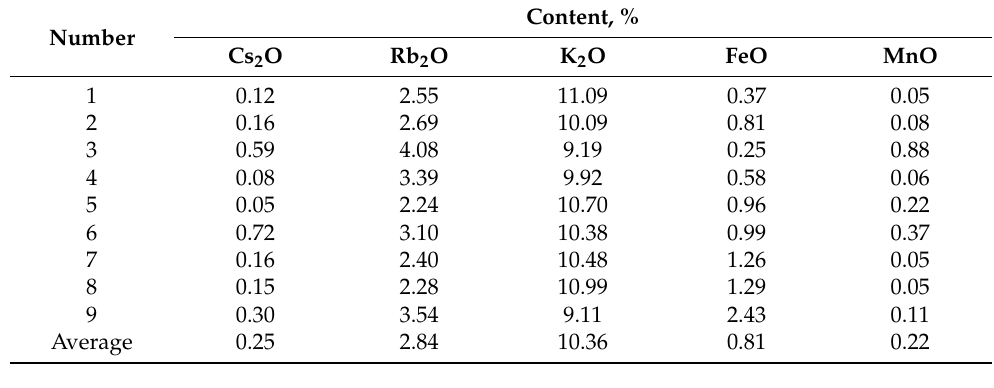
Table 7. Energy spectrum micro-domain composition analysis of mica. Table 5. Liberation degrees of pollucite and mica.